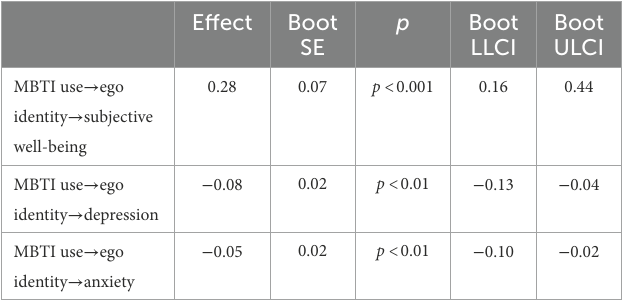
TABLE 3 Significant results of simple mediation